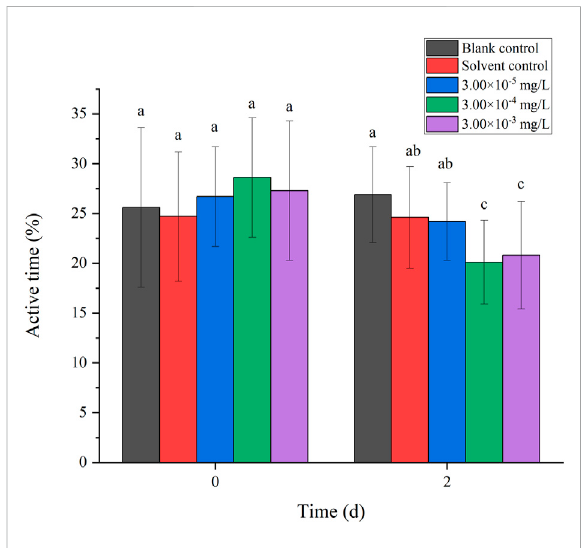
FIGURE 9 Effects of the mixture systems of fenvalerate and tebuconazole on the average velocity of zebra fi sh larvae locomotion.